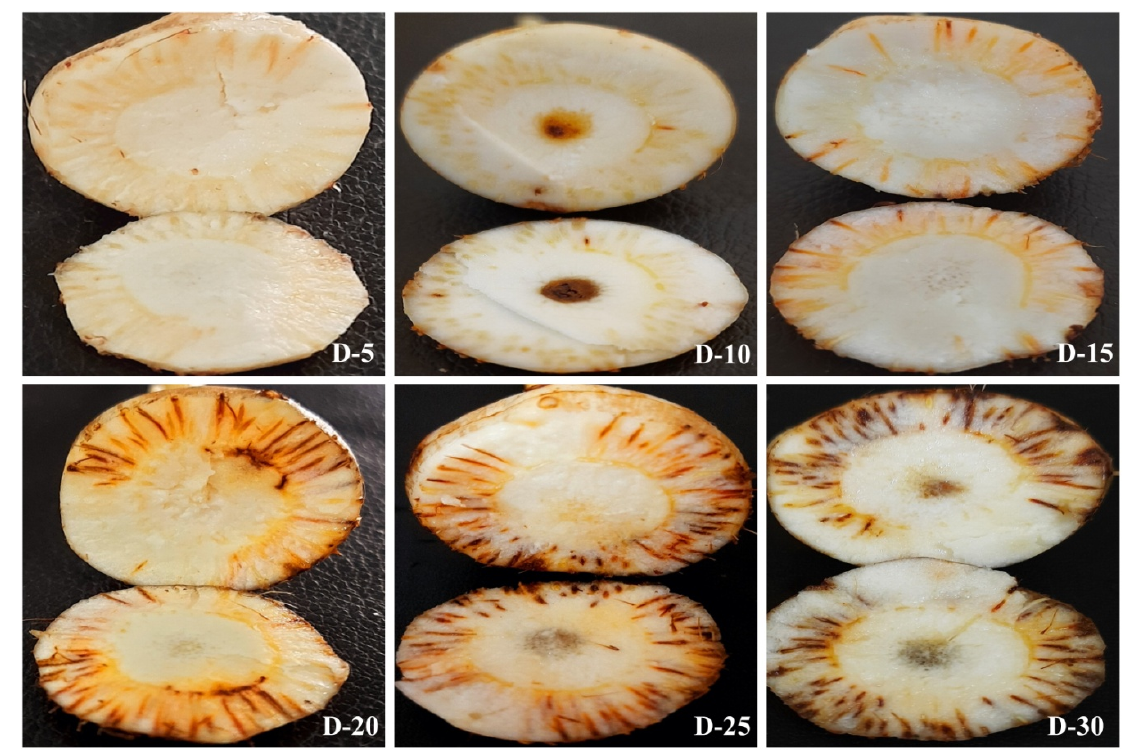
Figure 6. Symptoms of corm rot in the corm basal plate of T5 (root injury + Fox R1) treatment indicated the movement of Fox R1 from roots to the corm basal plate as no injury was given to corms.